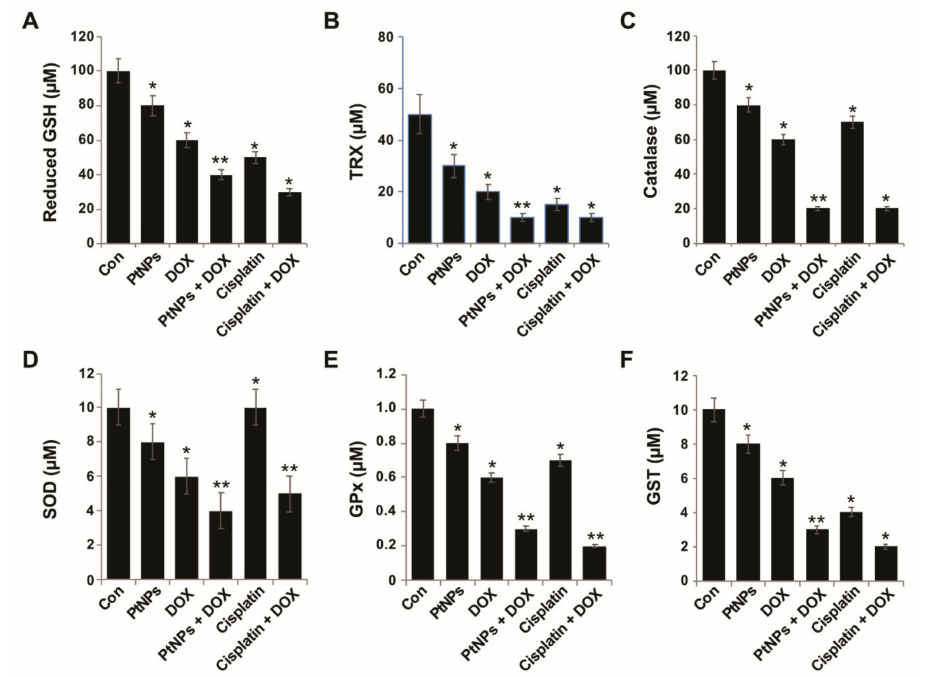
Figure 10. E ff ect of PtNPs and DOX on antioxidant markers. U2OS cells were treated with PtNPs (10 µ g / mL), DOX (1 µ g / mL), CIS (5 µ g / mL), or a combination of PtNPs (10 µ g / mL) and DOX (1 µ g / mL) or combination of DOX (1 µ g / mL) and CIS (5 µ g / mL) for 24 h. After incubation, the cells were harvested, washed twice with an ice-cold PBS solution, collected, and disrupted by ultrasonication for 5 min on ice. ( A ) Glutathione reductase activity (GSH) was measured by monitoring the rate of NADPH oxidation. Oxidation of NADPH was monitored spectrophotometrically in kinetic mode for 5 min at 340 nm. Glutathione reductase activity was proportional to the rate of absorbance decrease. ( B ) Thioredoxin reductase (TRX) activity was measured by monitoring the conversion of DTNB to TNB by reduced thiols. Cell lysate was mixed with 100 µ L of solution containing 5 mM DTNB and 250 µ M NADPH. Absorbance was monitored spectrophotometrically in kinetic mode for 5 min at 405 nm. Thioredoxin reductase activity was proportional to the di ff erence in TNB generation rate in samples. ( C ) Catalase activity was assayed by monitoring the rate of removal of exogenously added hydrogen peroxide in a colorimetric reaction. Absorbance was measured at 520 nm. Catalase activity was proportional to the di ff erence in absorbance between a control sample and treated sample. ( D ) Superoxide dismutase activity was assayed by monitoring the rate of removal of exogenously added superoxide. Superoxide dismutase activity was proportional to the di ff erence in absorbance increase rate between a control sample and the treated sample. ( E ) Glutathione peroxidase activity (GPx) was measured indirectly by monitoring NADPH consumption in a coupled reaction with glutathione reductase and ( F ) Glutathione S-Transferase (GSTs) activity was assayed spectrophotometrically at 25 ◦ C with reduced glutathione (GSH) and 1-chloro-2, 4-dinitrobenzene (CDNB) as substrates. GST concentrations are expressed as micromoles. Di ff erences between the treated and control groups were measured using Student’s t -test and statistically significant di ff erences are indicated by * ( p < 0.05). The results are presented as mean ± standard deviation of three experiments. * p < 0.05 was considered significant; ** p < 0.01 was considered highly significant and *** p < 0.001 was considered very highly